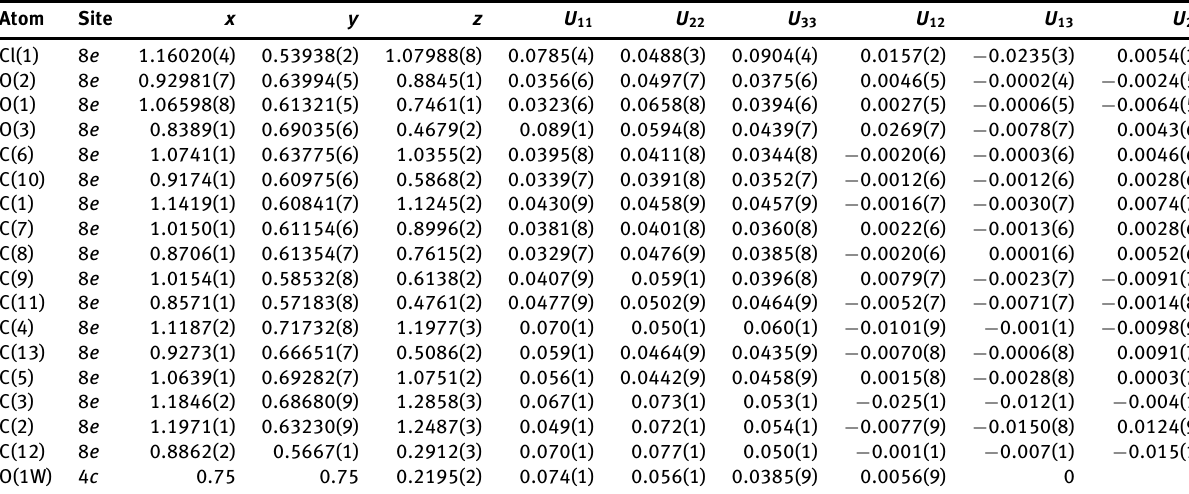
Table 3: Atomic displacement parameters (Å 2